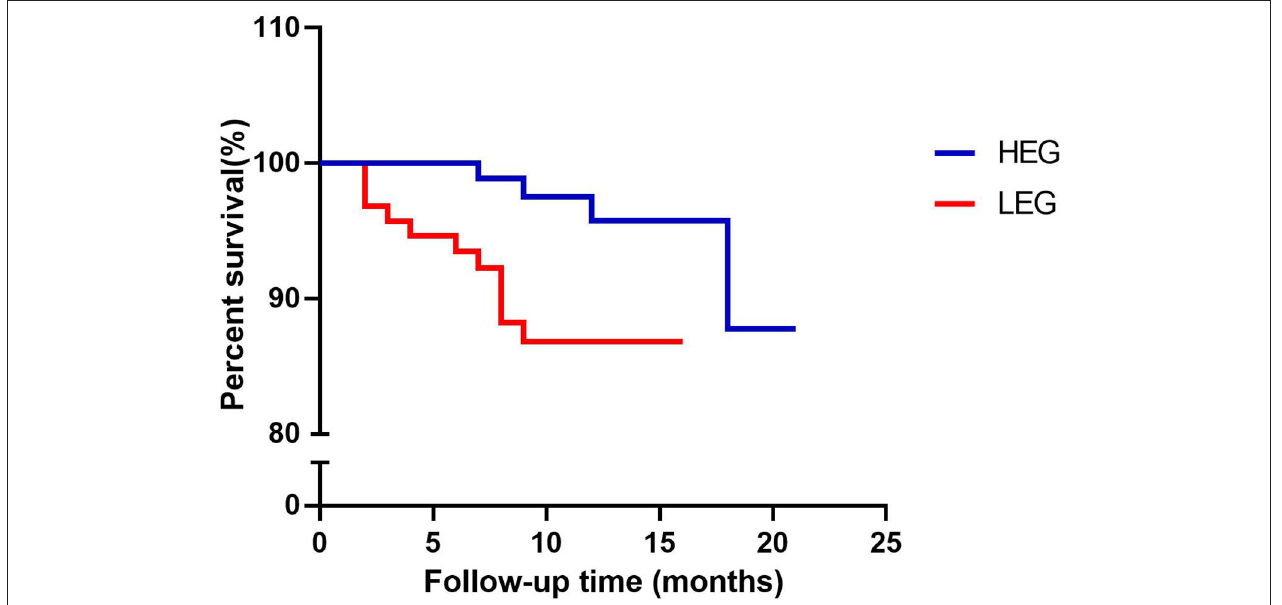
FIGURE 2 | Kaplan–Meier curves of event-free survival with follow-up time. HEG, high execution group; LEG, low execution group.